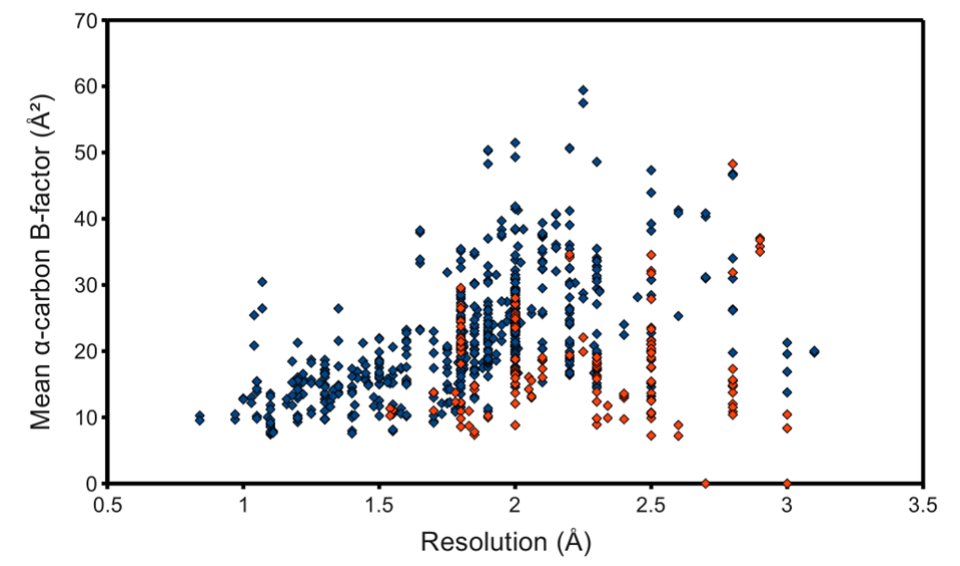
Figure 3. Quality of deposited PR structures. Monomers that passed the B- factor cut-off of 2.15 Å 2 are marked blue, whereas those that failed are red. NMR structures, to which the concept of resolution does not apply, were not used for this